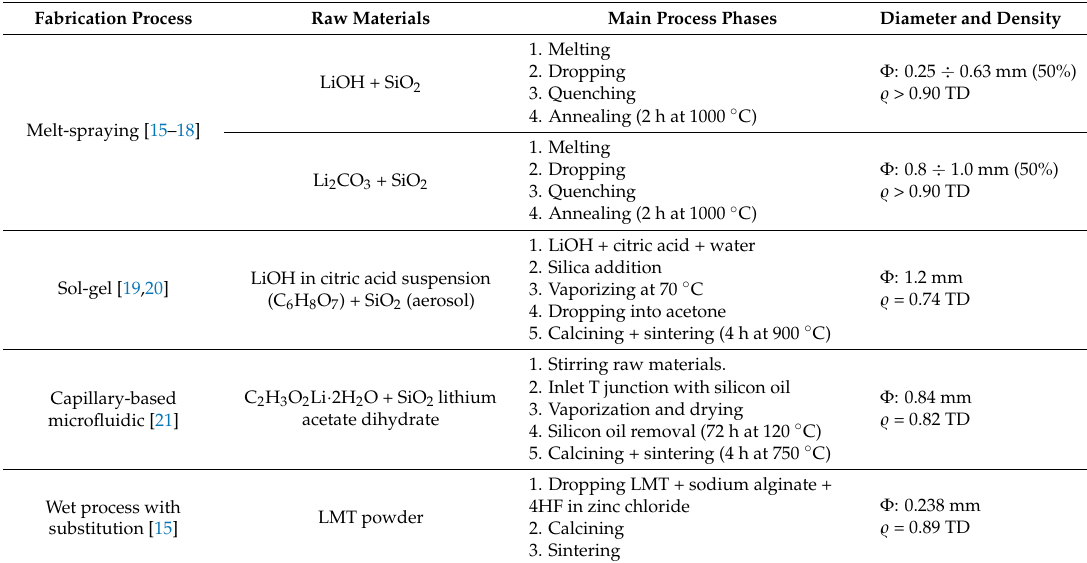
Table 1. Pebble fabrication processes